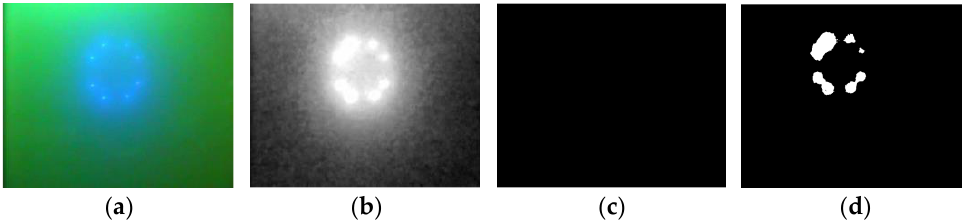
Figure 7. Problems of guidance lamp extraction caused by variations in camera poses/positions: ( a ) original image; ( b ) blue components; ( c ) loss of guidance lamps; ( d ) adjacent guiding lamps merging together or overlapping each other.